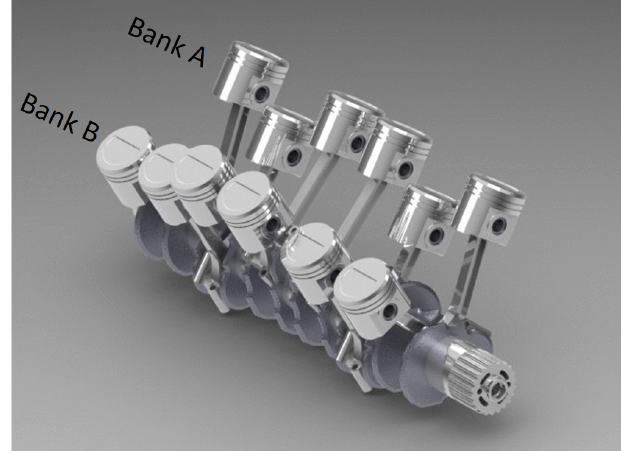
Figure 2. V12 engine: 12 cylinders are arranged in two banks of six cylinders set at an angle to one another